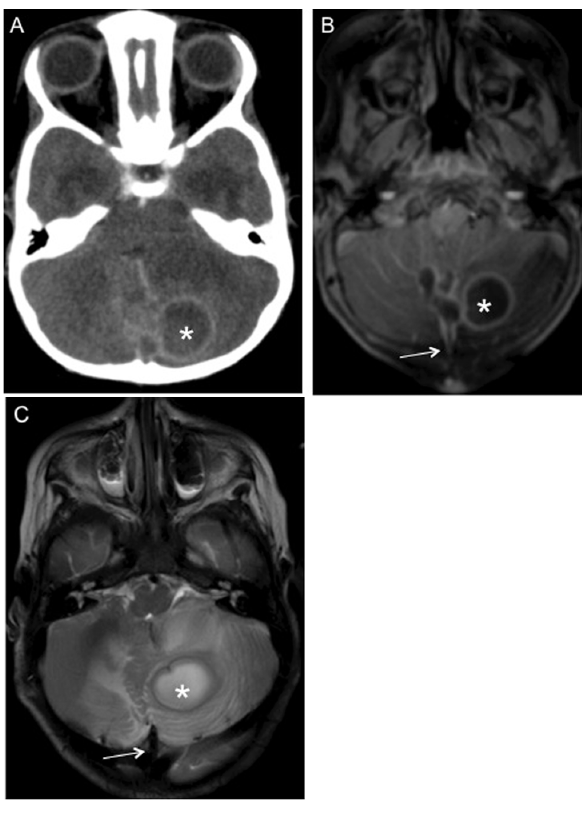
Figure 1 - Cerebellar abscess in a child associated with a cranial dermal sinus. a Preoperative CT scan after contrast showing a left-hemisphere cerebellar abscess dislodging the brainstem and fourth ventricle (*) b Axial T 1 -weighted after gadolinium and c axial T 2 -weighted magnetic resonance (MR) images showing a space-occupying lesion (asterisks) associated with cerebellar edema and an occipital dermal sinus tract